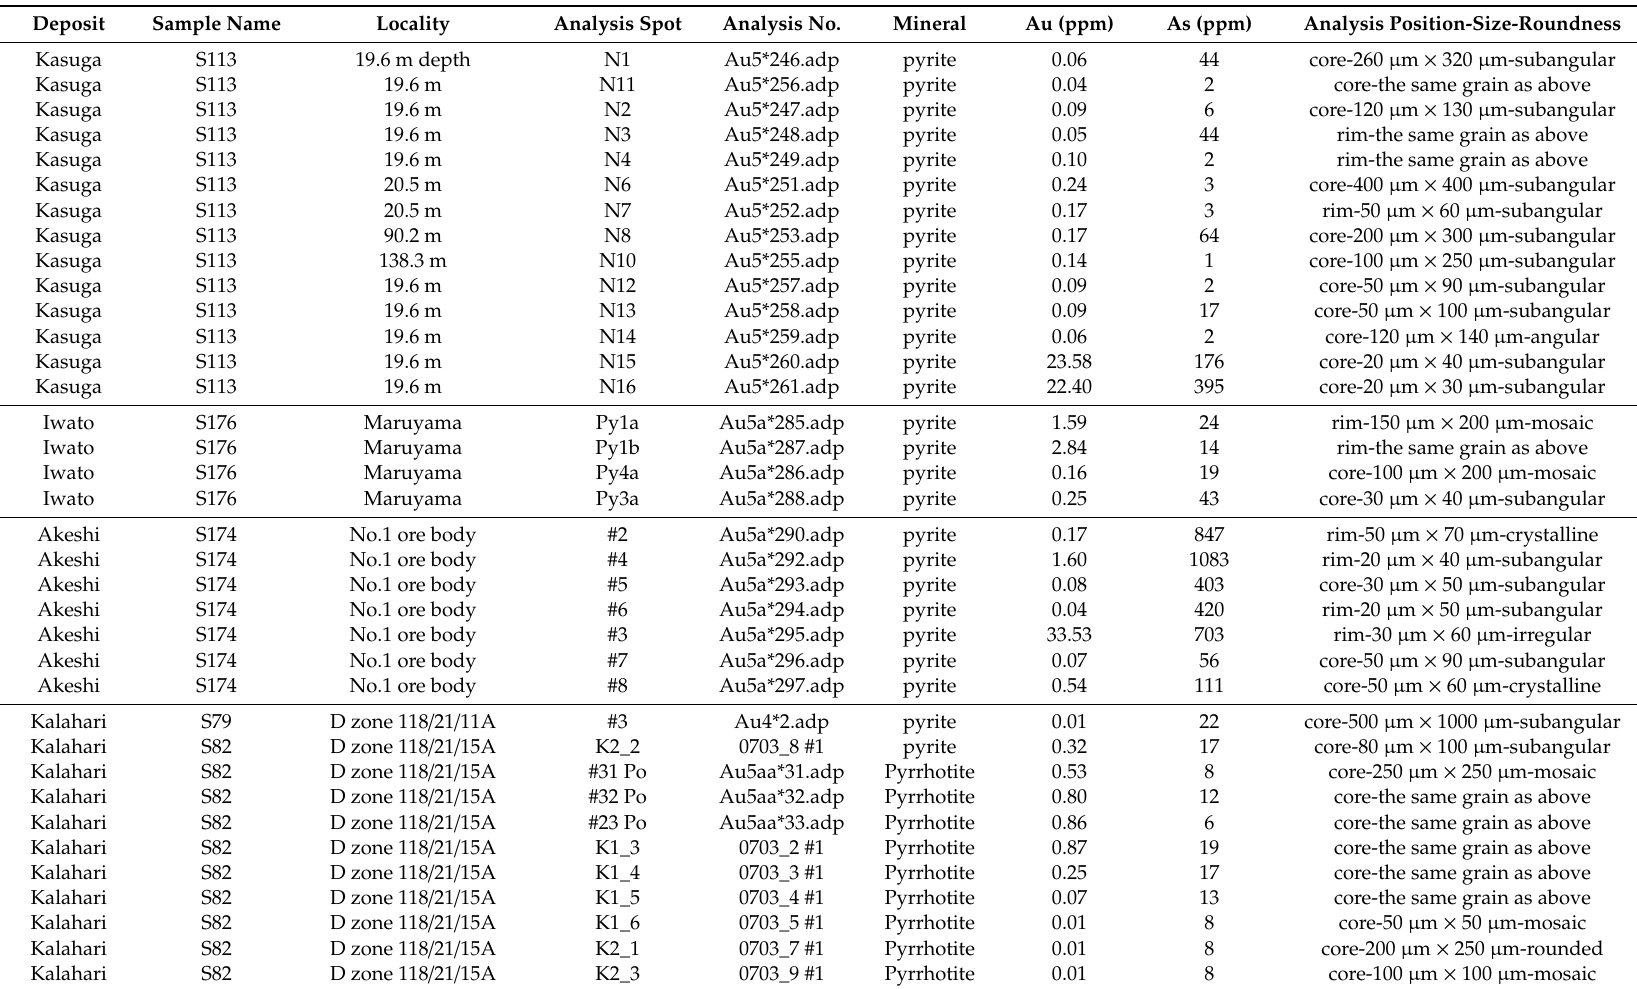
Table 2. Results of secondary ion mass spectrometry (SIMS)